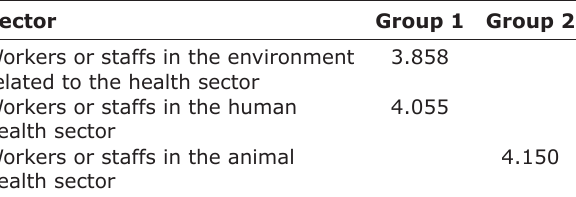
Table-1: Multiple comparison of implementation in one health information between workers or staffs in each sector by Duncan method at alpha ( α